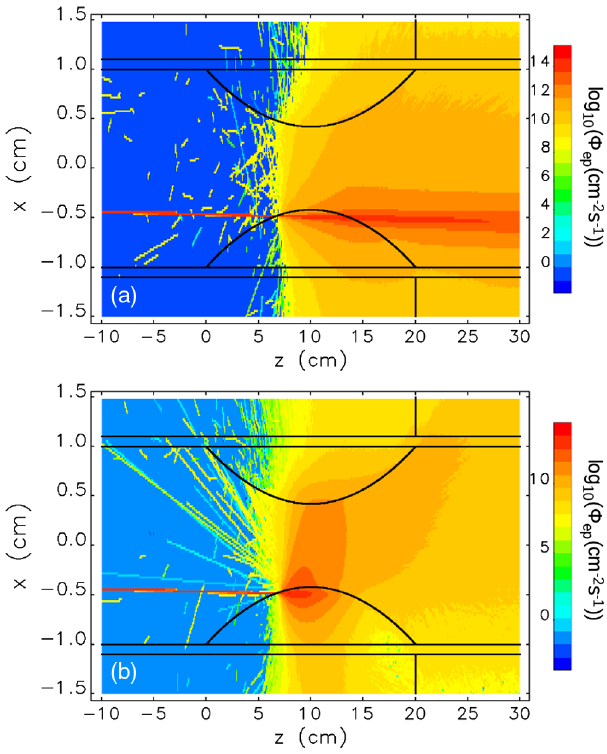
FIG. 3. Static MARS simulation of combined electron-positron flux in collimators fabricated from (a) aluminum and (b) tungsten. The x - y - z voxel dimensions are 0 . 02 cm × 0 . 1 cm × 0 . 1 cm centered at beam elevation ( y ¼ 0